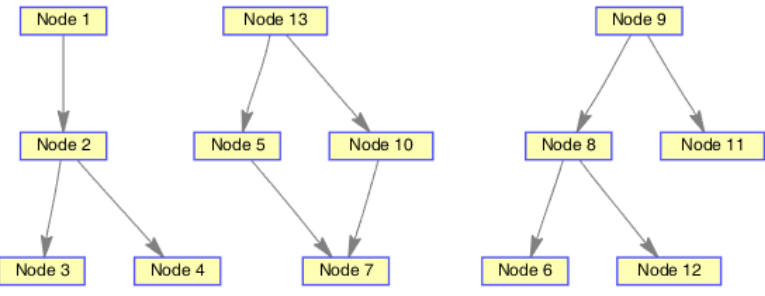
Figure 9. The state estimation of group targets at k = 20.